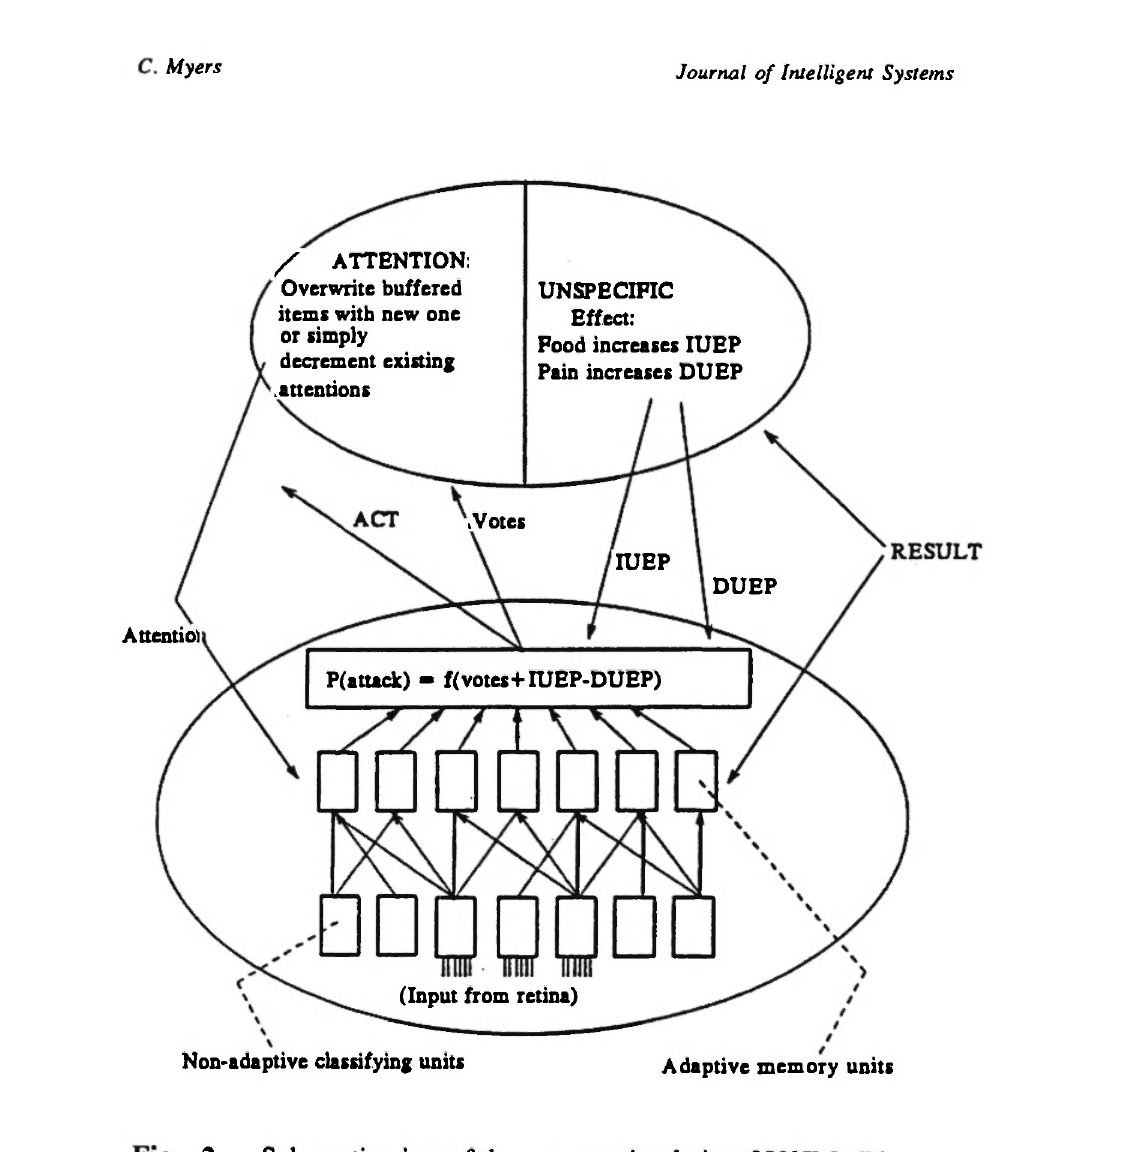
Schematic view of the octopus simulation OVSIM. Binary "visual" input feeds into 4200 non-adaptive units which classify it in terms of features such as brightness or edge